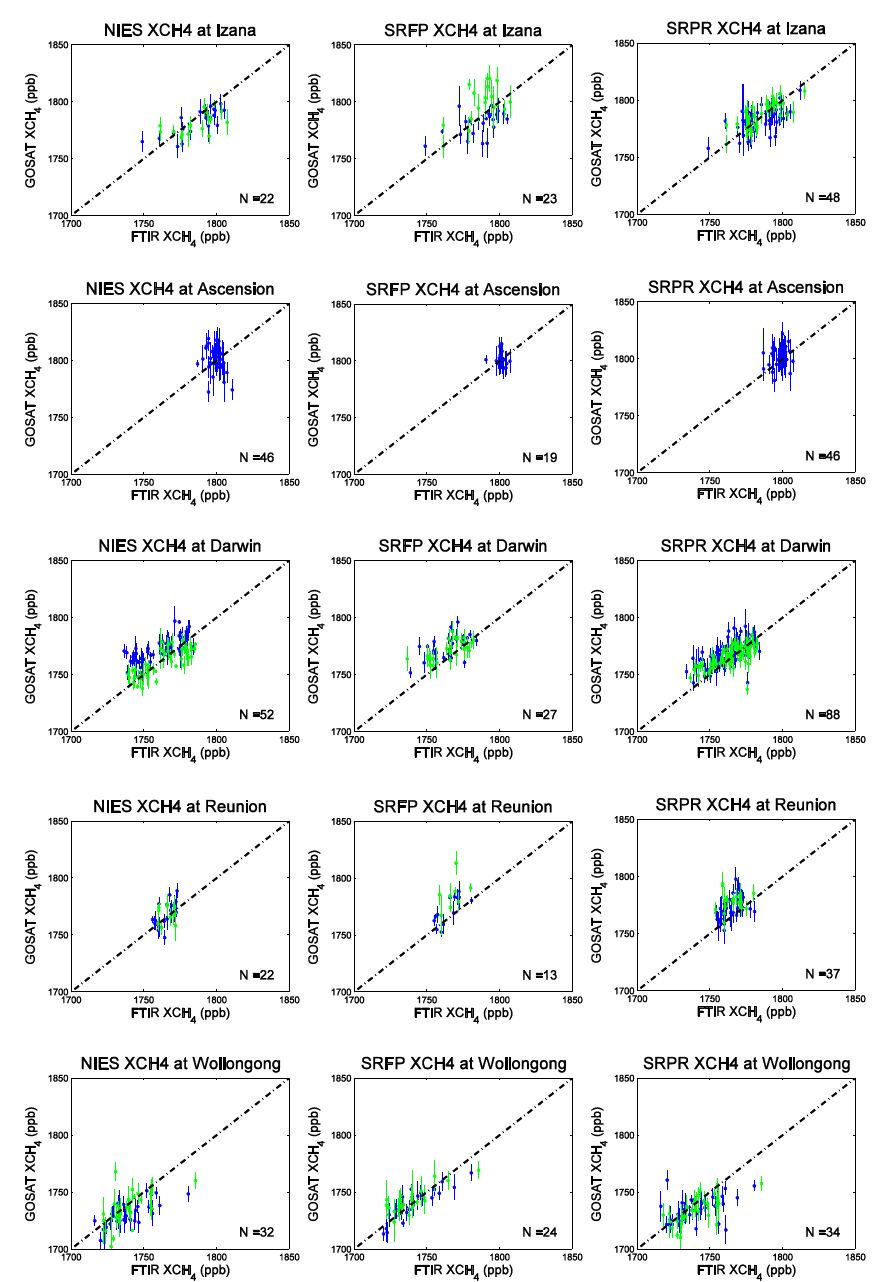
Figure 7. The scatter plots of daily median of XCH 4 from FTIR measurements and different GOSAT algorithms retrievals over 5 TCCON sites. Only the ocean and land data co-existing within ± 1 day are selected; N is the total number of days. The error bar represents the standard deviation of all the measurements within ± 1 day. The blue and green points present the glint mode over ocean and the normal nadir mode above land,